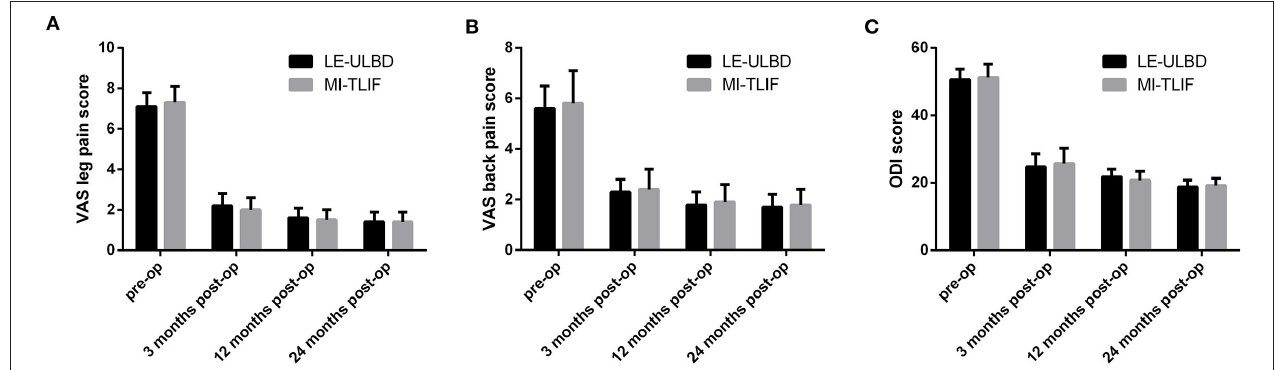
FIGURE 5 | The mean visual analog scale (VAS) scores for leg and back pain, and Oswestry disability index (ODI) scores. (A) VAS scores for leg pain; (B) VAS scores for back pain; (C) ODI scores. Pre-op, pre-operative; post-op, post-operative; LE-ULBD, lumbar endoscopic unilateral laminotomy bilateral decompression; MI-TLIF, minimally invasive transforaminal lumbar interbody